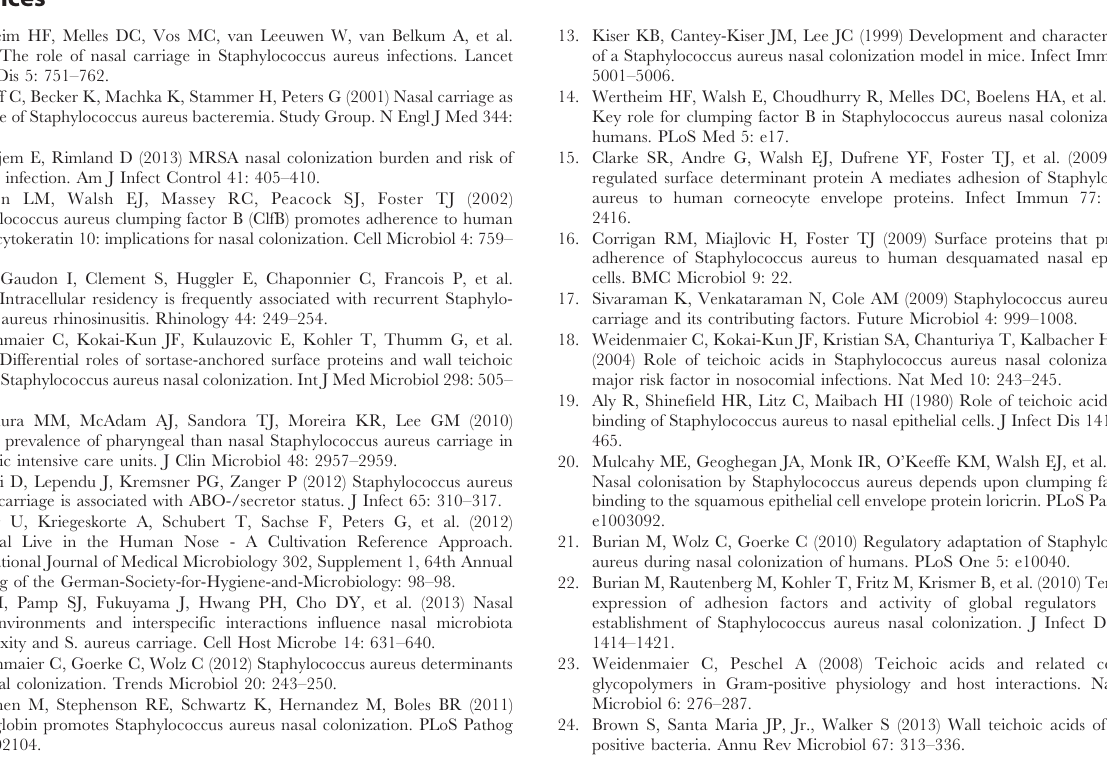
WTA repeating units and the actual spacing of the charges are required for SREC-I binding (B). Figure S8 Charge dependency of WTA dependent adhe- sion to nasal epithelial cells and SREC-I dependent modulation of USA100 nasal colonization. Adhesion to CRNECs, under shear stress conditions in ibidi chamber slide assays, was monitored after preincubation of the bacterial inoculums with different MgCl 2 concentrations. The mean and SD of 4 independent experiments are shown. Statistical analysis was performed by one-way ANOVA with Bonferroni’s multiple comparison test (A). Nasal colonization in the cotton rat model was tested with USA100 (B). Bacterial numbers were determined 6 days after inoculation. 15 min prior to inoculation cotton rats were pretreated with 2 m g anti-SREC-I Fab 2 -fragment per nose. After 6 days the noses were dissected and the bacterial CFU was evaluated on S. aureus selective highchrome agar. Statistical analysis was performed by one-way ANOVA with Bonferroni’s multiple comparison test (B). Significant differences vs. wild-type without MgCl 2 are indicated by one ( P , 0.05), two ( P , 0.01), or three ( P , 0.001) asterisks